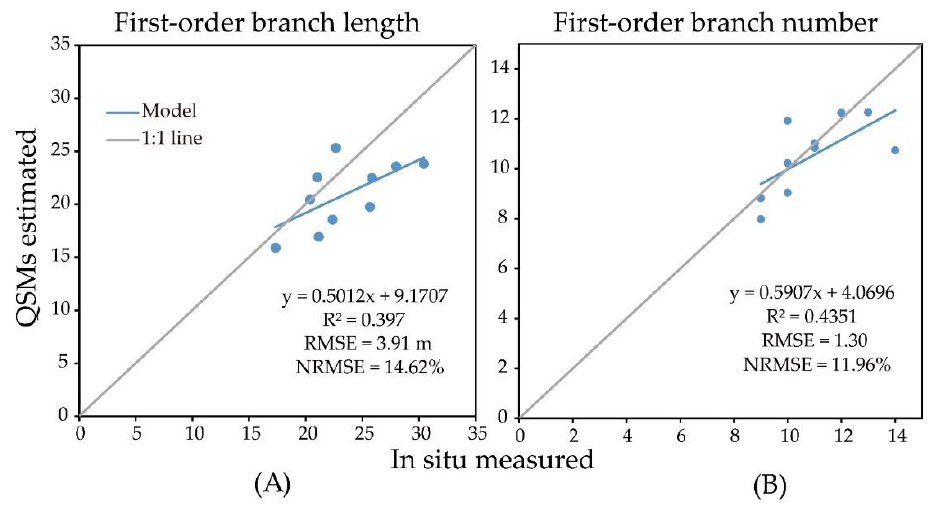
Figure 9. Comparison of in situ measured branch information(length/number) of the first-order branch with first-order branch information from QSMs based on backpack-LiDAR. ( A ) Length; ( B ) number.